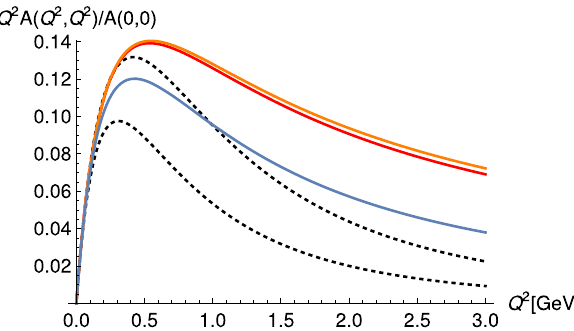
= Q 2 = Q 2 from 1 2